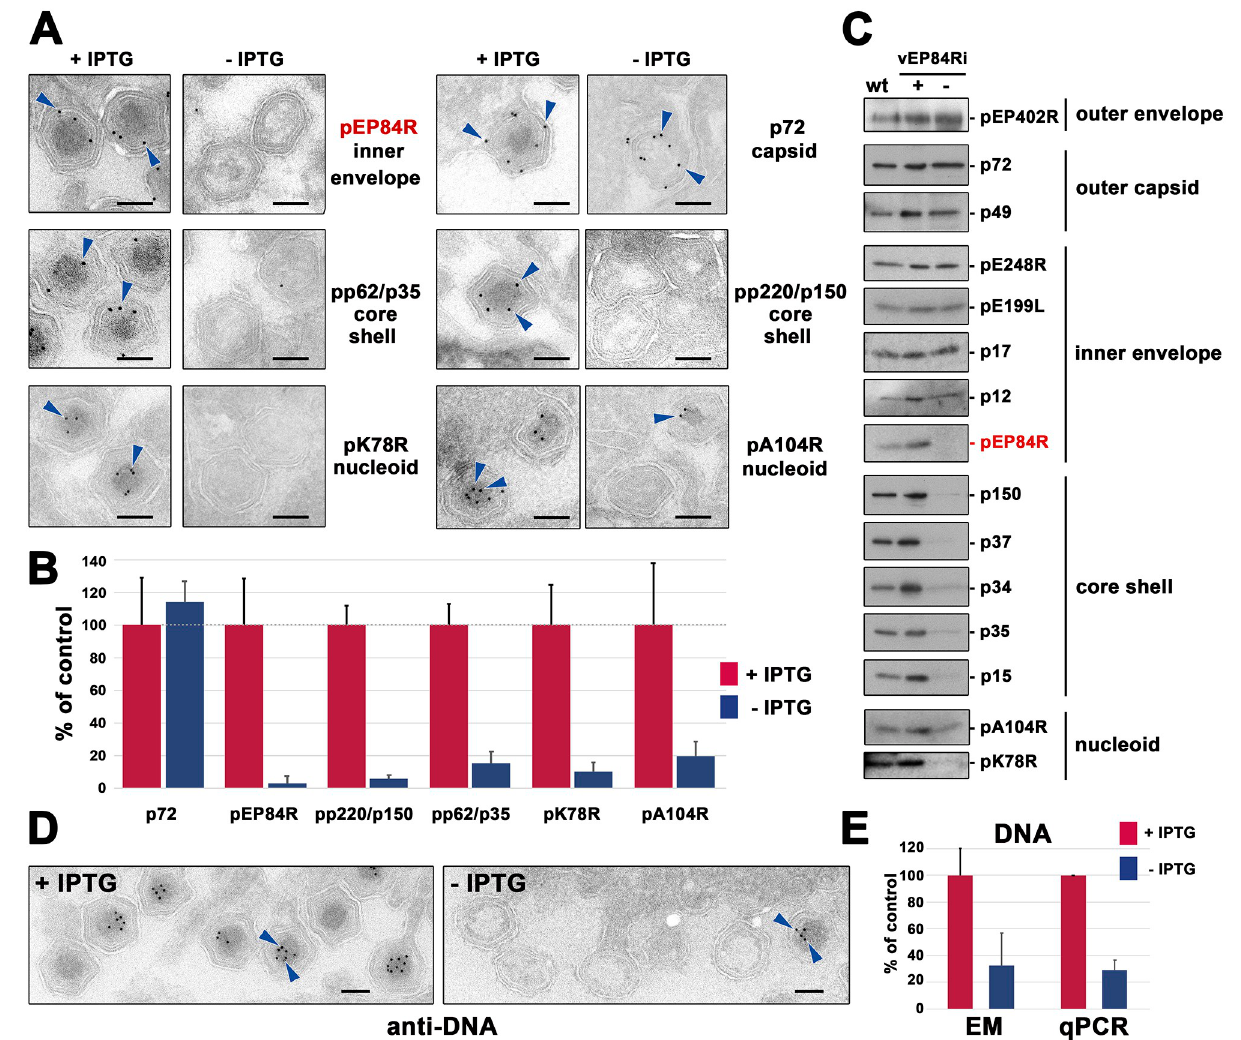
Fig 3. Defective vEP84Ri - particles lack core shell and nucleoid components. (A) Immuno-EM of control (+IPTG) and defective (-IPTG) vEP84Ri particles at budding areas. Thawed cryosections of vEP84Ri-infected cells were incubated with antibodies against the inner envelope protein pEP84R, the outer capsid protein p72, the core shell proteins pp220/p150 and pp62/p35, and the nucleoid, DNA-binding proteins pK78R and pA104R, followed by protein A-gold (10 nm). The arrowheads indicate representative labeling. Bars, 100 nm. (B) Quantification of immunogold labeling. The number of gold particles per icosahedral virus detected under permissive (+IPTG) and non-permissive (-IPTG) conditions was quantified from 5–10 different budding areas. Data are expressed as a percentage ( ± SD) of the mean labeling density detected in control (+IPTG) condition (C) Protein composition of defective vEP84Ri particles. Equivalent amounts of purified extracellular control vEP84Ri + and defective vEP84Ri - particles were analyzed by Western immunoblotting for representative virion proteins localized at different layers. As a control, wild type (wt) ASFV particles were also analyzed. (D) DNA labeling of vEP84Ri particles. Cryosections of vEP84Ri-infected cells in the presence or absence of IPTG were incubated with anti-DNA mAb, a bridging rabbit anti-mouse antibody and protein A-gold (10 nm). The arrowheads indicate representative nucleoid labeling of control mature particles (+IPTG) as well as a small fraction of defective full particles (-IPTG) at budding areas. Bars, 100 nm. (E) DNA content of vEP84Ri particles. Left (EM): DNA immunolabeling of control (+IPTG) and defective (-IPTG) particles was quantified at different budding areas ( > 100 particles per condition). Data are expressed as a percentage ( ± SD) of positive labeling ( > 1 gold particle/virus particle) detected in control vEP84Ri (+IPTG) viruses. Right (qPCR): Percoll-purified vEP84Ri + and vEP84Ri - particles were subjected to DNA extraction and qPCR with a set of primers specific for ASFV gene B646 . The amount of purified particles used was normalized for MCP content by western blot. Data are expressed as a percentage ( ± SD) of the DNA content detected in control vEP84Ri (+IPTG) particles.